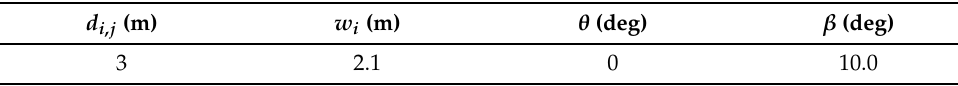
Table 3. Parameters used for Jazbina vineyard model creation.